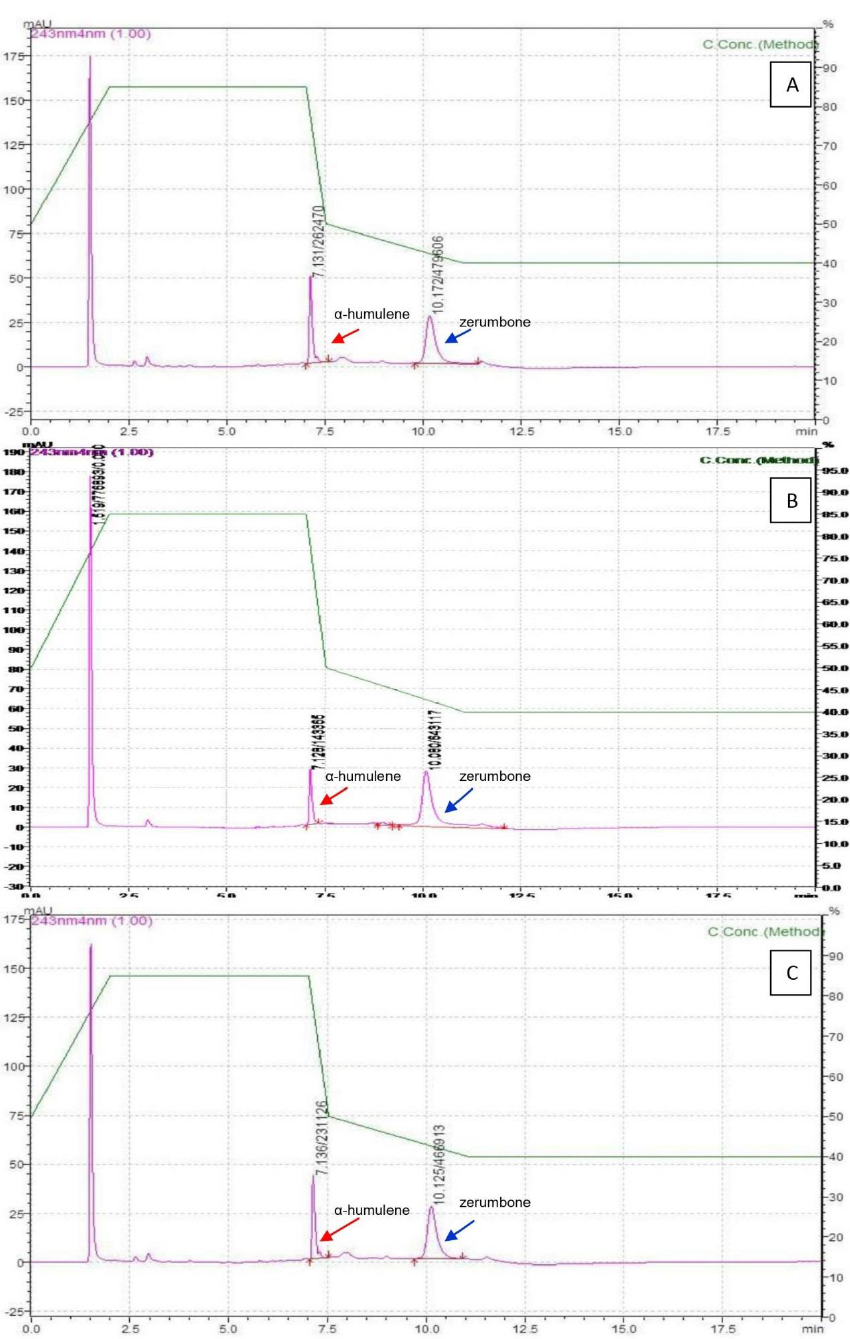
Figure 7. The HPLC chromatograms of Z. zerumbet samples. ( A ) AdRC elicited with 400 µM MeJa + 400 µM SA; ( B ) AdRC without elicitors; ( C ) rhizome MeJa + 400 µ M SA; ( B ) AdRC without elicitors; ( C )